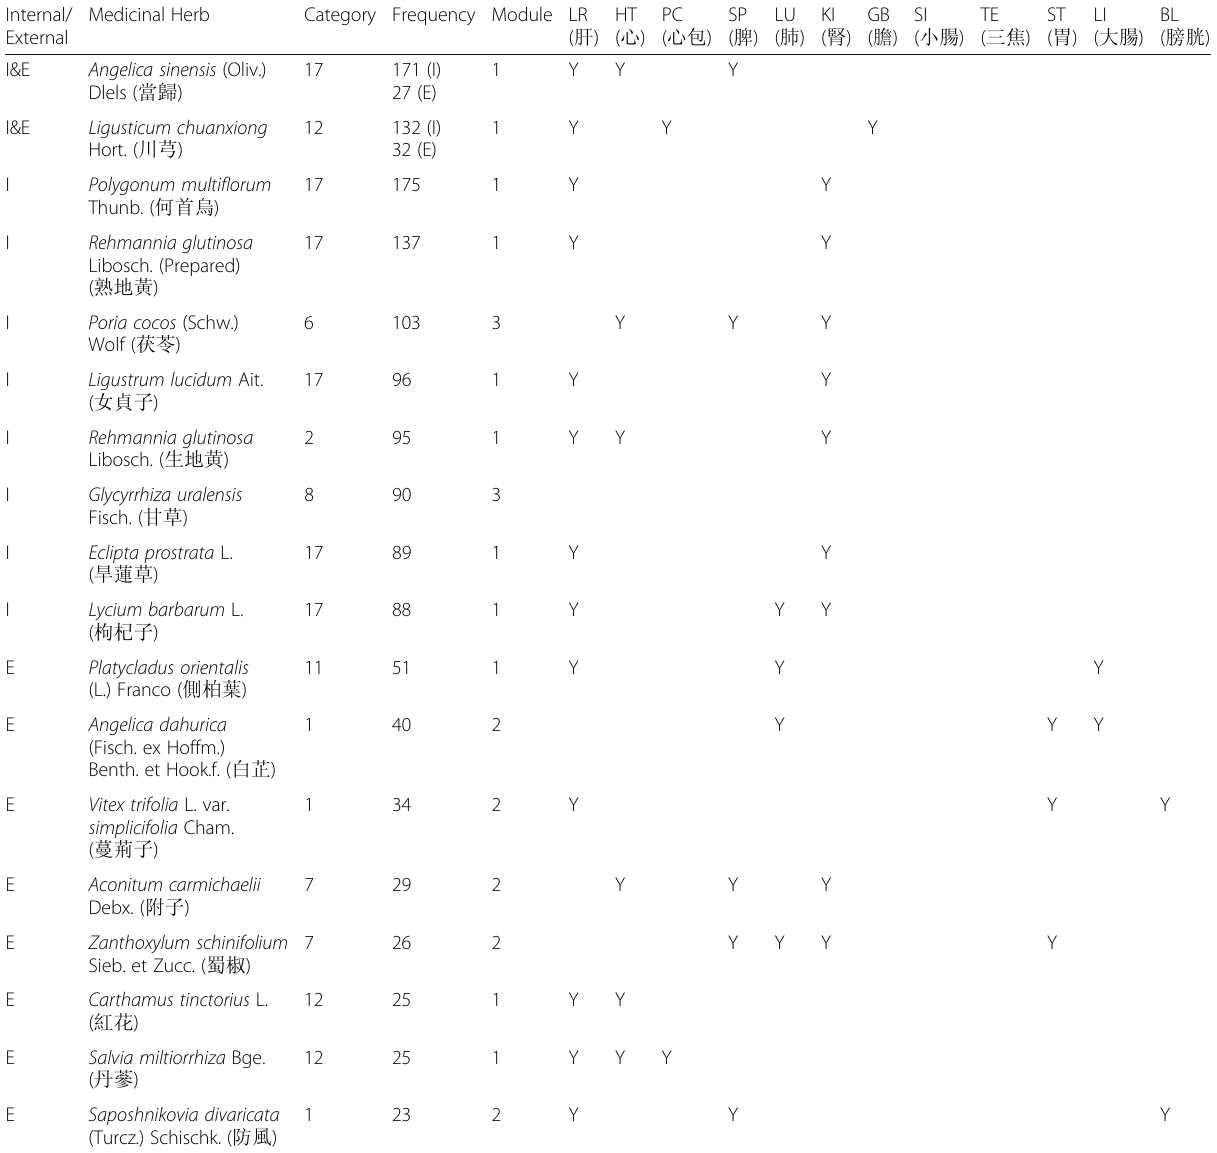
Table 1 Frequency, module, and meridian tropism of the top 10 internal and external medicinal herbs Internal/ Medicinal External